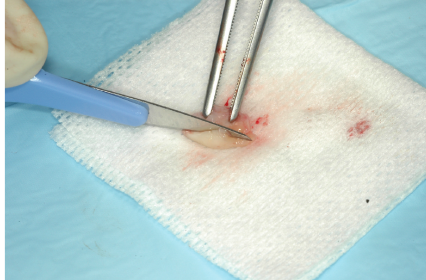
Figure 9: Dissection of the graft to remove epithelium.